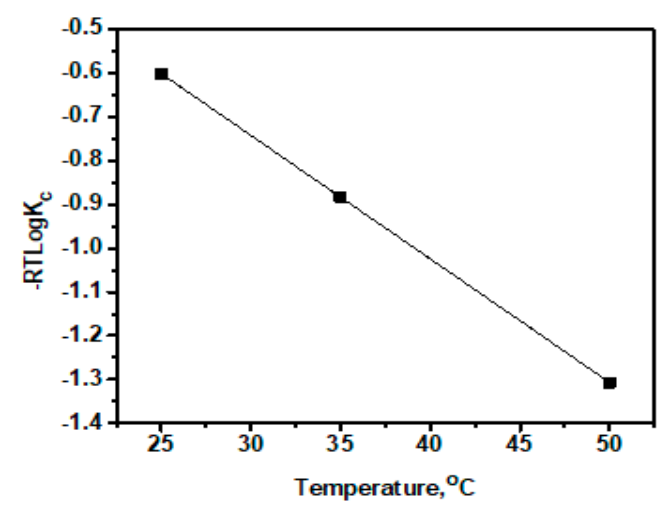
Figure 5. Temperature vs. ∆ G plot to understand the influence of temperature on the adsorption efficiency of La 2 O 3 (0.1 g/L) for As(V) (10 mg/L), at pH 6, and at 25 °C for 60 min equilibrium.